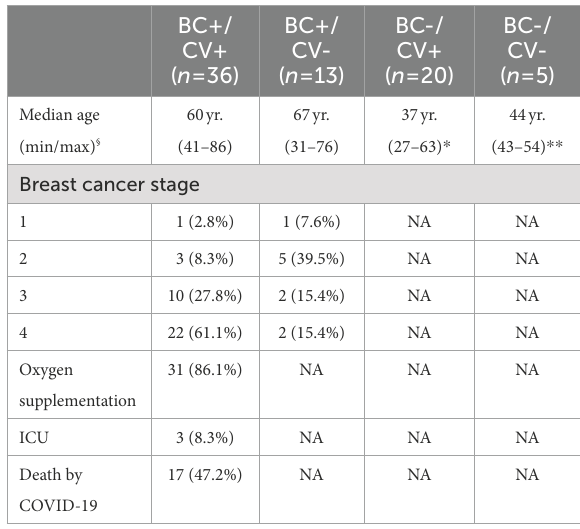
TABLE 1 Characterization of the women included in the study and their distribution over the study